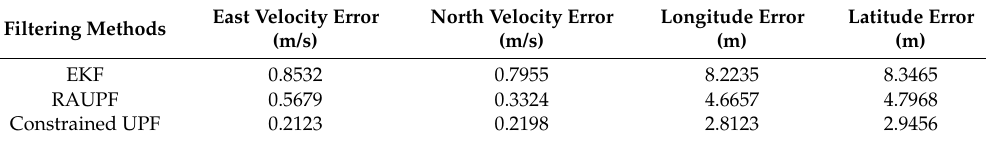
Figure 8. North velocity and latitude errors under the wind speed of 20 m/s. Table 1. Mean errors of velocity and position under the wind speed of 10